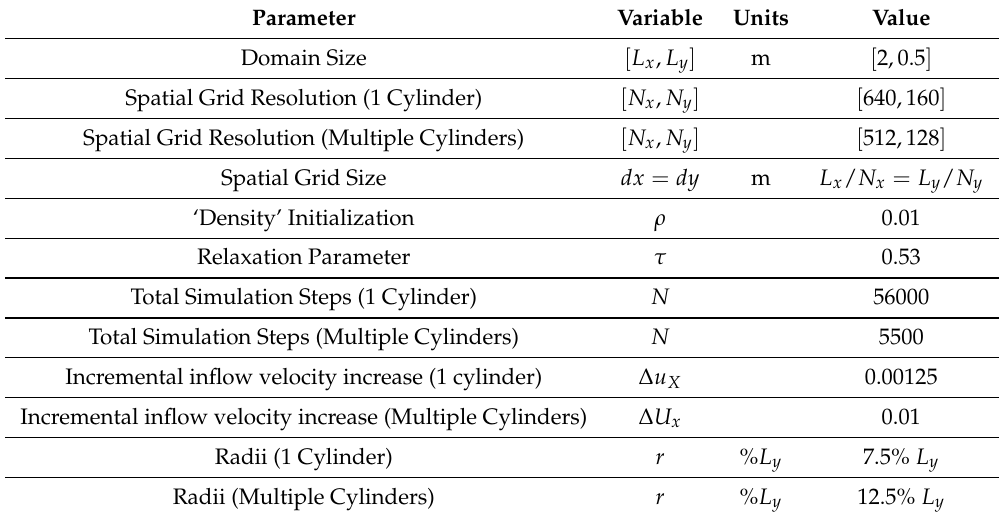
Table 7. Numerical parameters for flow past one or more cylinders using the Lattice Boltzmann